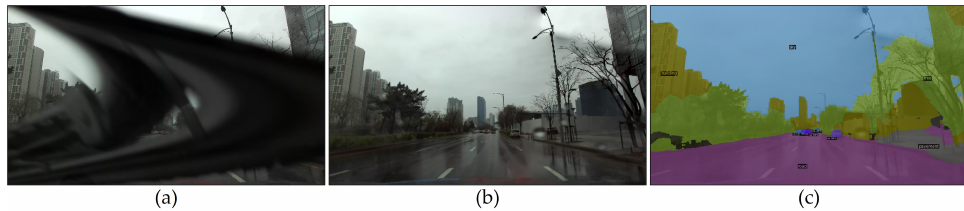
Figure 16. Panoptic segmentation result with leveraging BTS: ( a ) original wiper-occluded image; ( b ) restored image with a wiper mask from BTS; ( c ) panoptic segmentation result. BTS